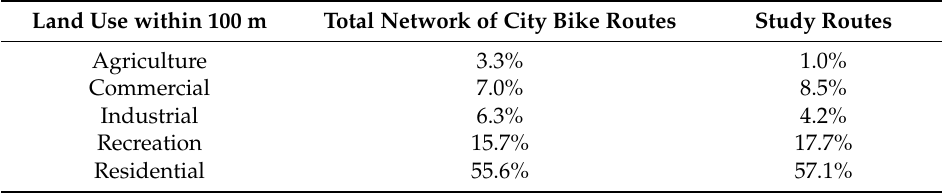
Table 1. Land uses located within 100 m of the study route compared with the city designated bicycling